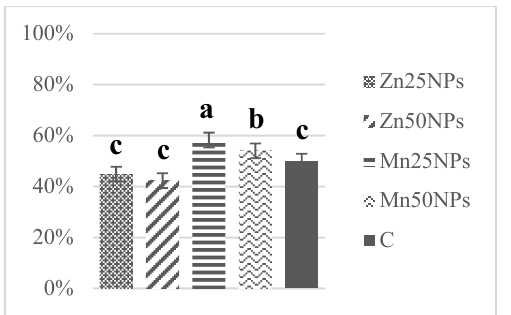
Figure 2. Percentage of sperm with intact plasma membrane (%) in samples stored for 24 h with or without (C) the addition of ZnNPs and MnNPs. * Different letters (a, b, c) indicate statistically significant differences at p ≤ 0.05. The bars with various letters are significantly different from one another.